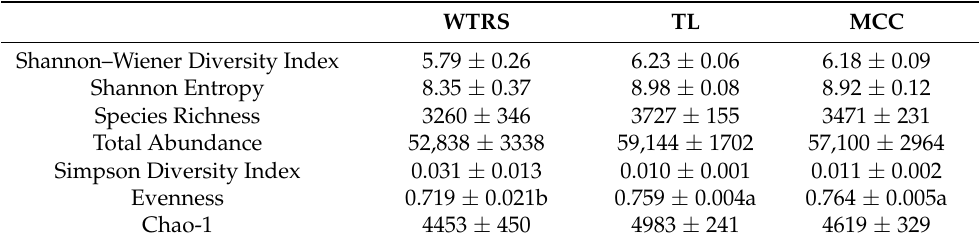
Table 1. Richness estimates and diversity indices (means ± SE) for 16S rRNA libraries of tomato rhizosphere soils. Different letters indicate a significant difference among tomato varieties ( p < 0.05, ANOVA, Dunn’s post hoc-Bonferroni corrected p values) when exist. WTRS: wild tomato related species; TL: tomato landraces; MCC: modern commercial cultivars.